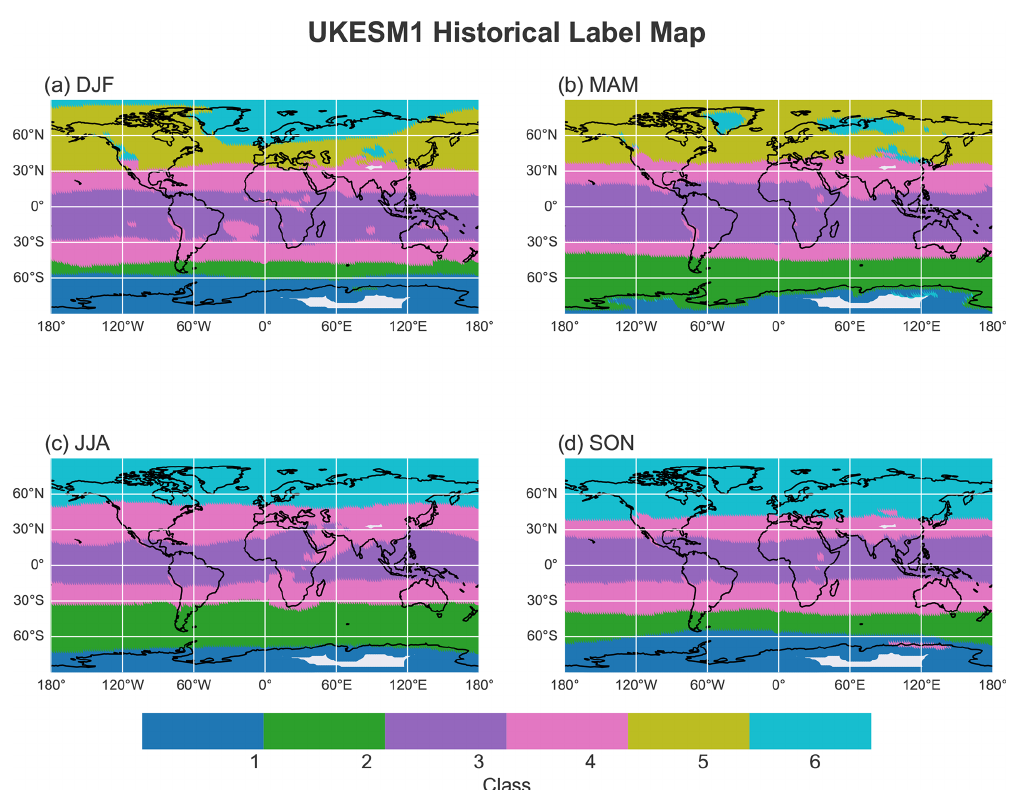
Figure 3. Map of profiles color coded with the class they have been attributed to for model historical data (seasonal mean profiles covering 2009–2014 at each model grid cell) at